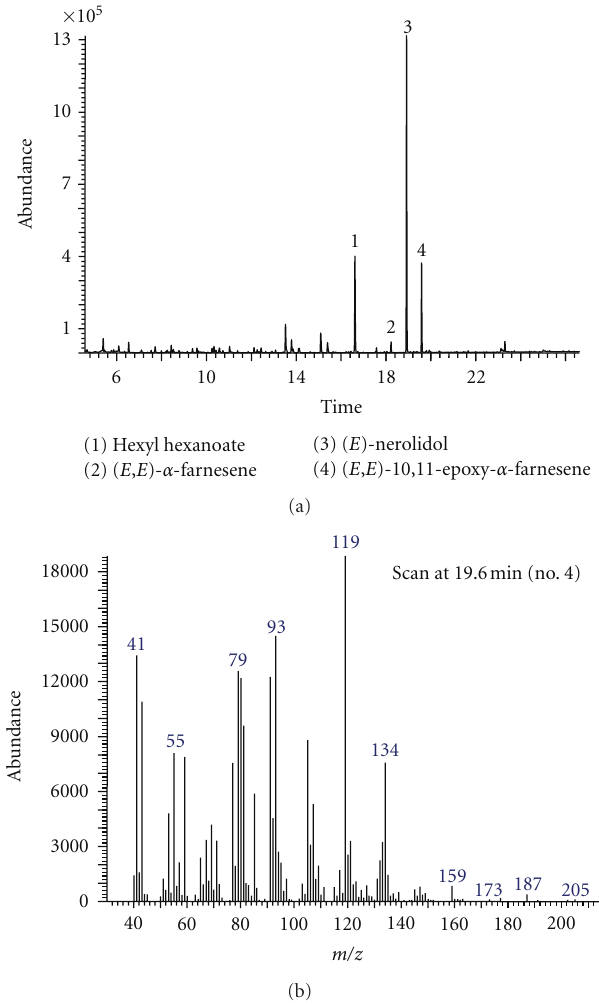
Figure 1: Total ion chromatogram of an aeration extract of male Amblypelta lutescens lutescens and EI mass spectrum of compound 4 . Column: Rtx-5MS (30m × 0.25 mm i.d. × 0.25 μ m), 50 ◦ C (5min) to 260 ◦ C at 10 ◦